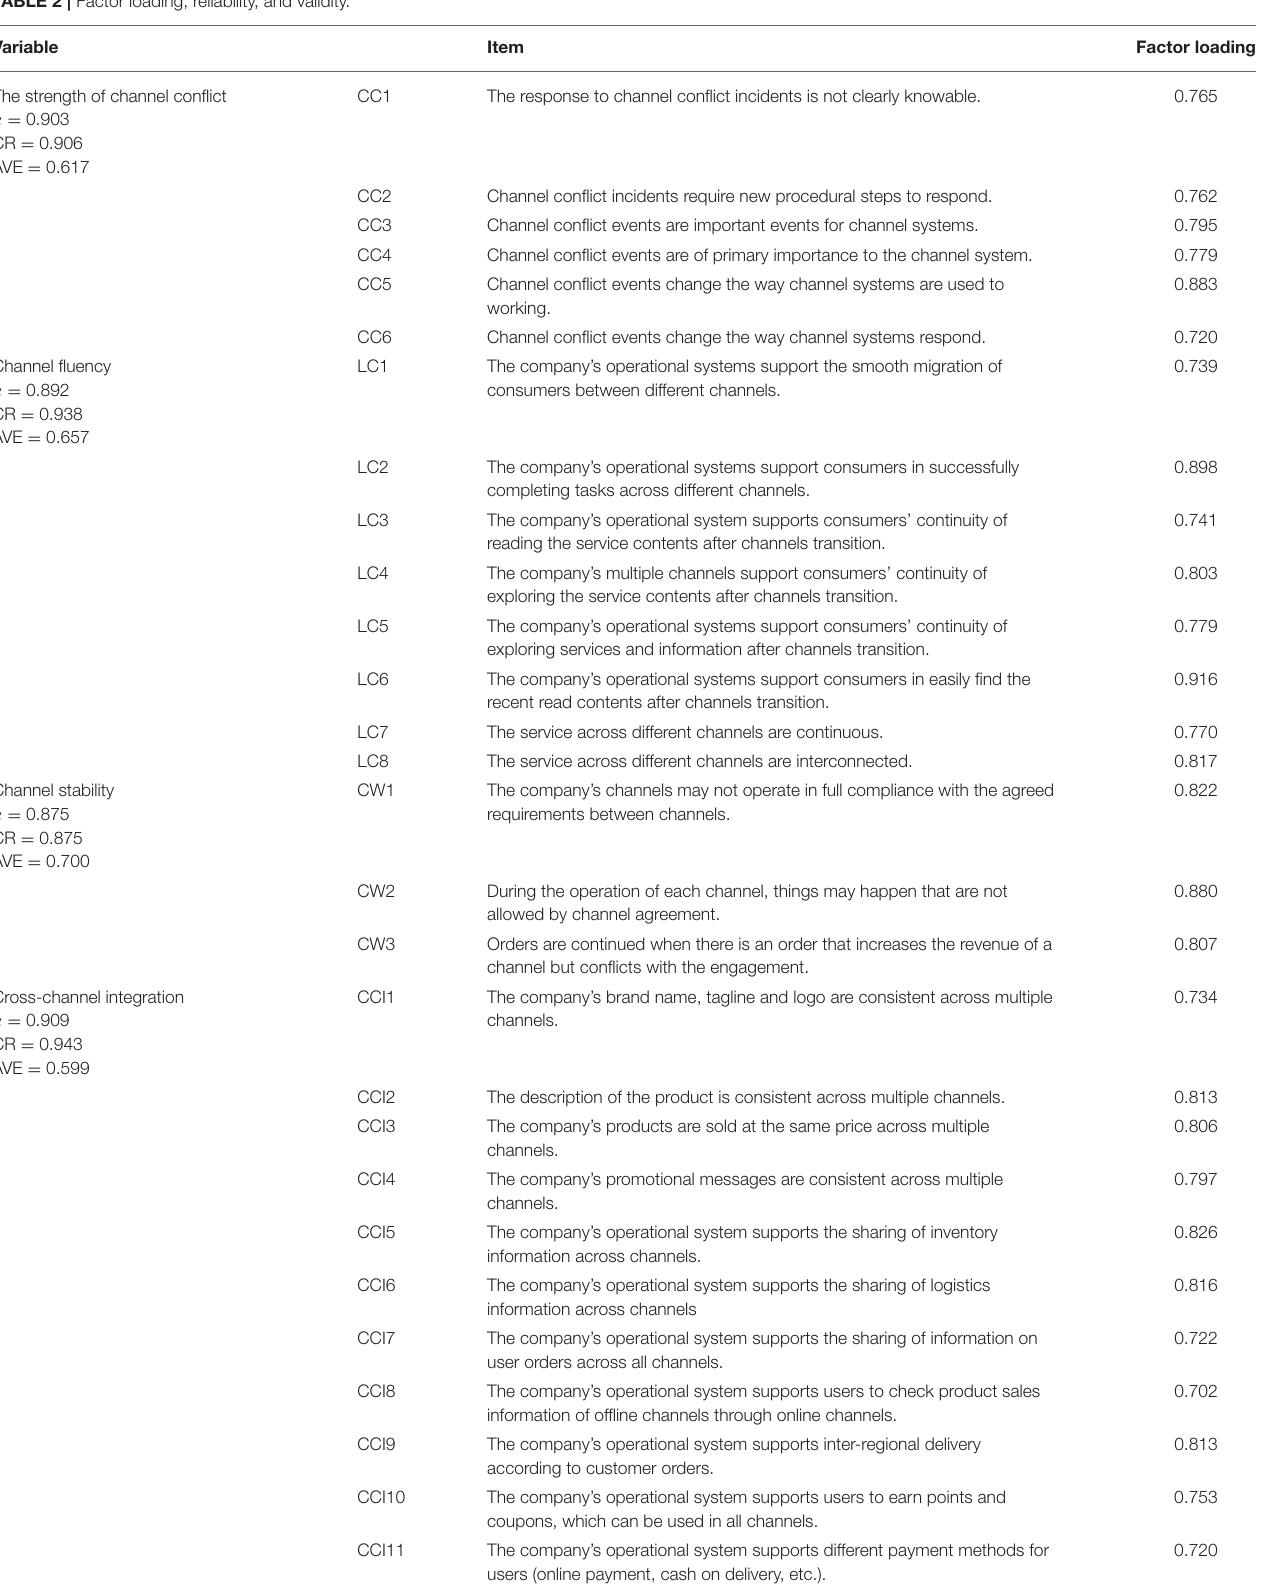
TABLE 2 | Factor loading, reliability, and validity. Variable